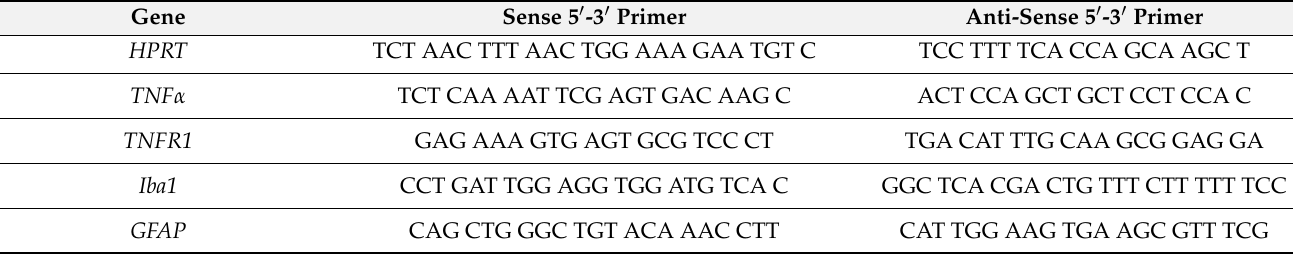
Table 2. List of primers used for qPCR experiments. Sense 5 (cid:48) -3 (cid:48) Primer Anti-Sense 5 (cid:48) -3 (cid:48)